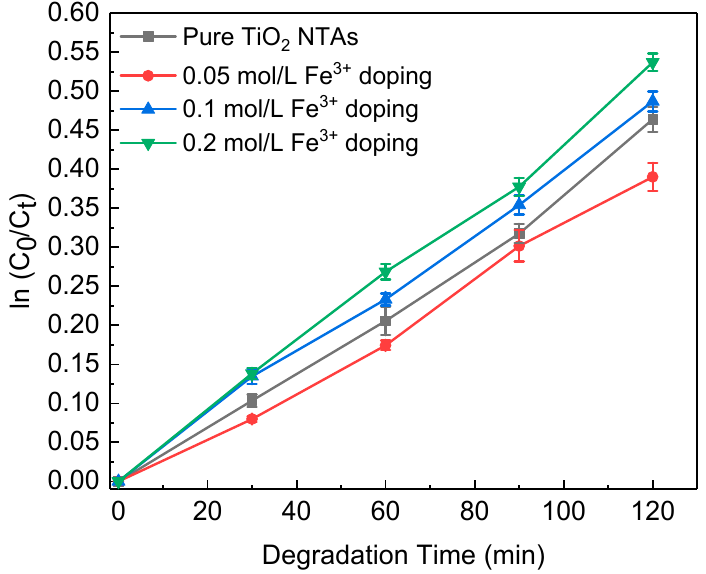
Figure 7. Concentration change of methyl orange (MO) as a function of irradiation time under ultraviolet light for pure and Fe 3 + doped TiO 2 NTAs. C 0 , and C t were the concentrations of MO before and after ultraviolet light irradiation, respectively.